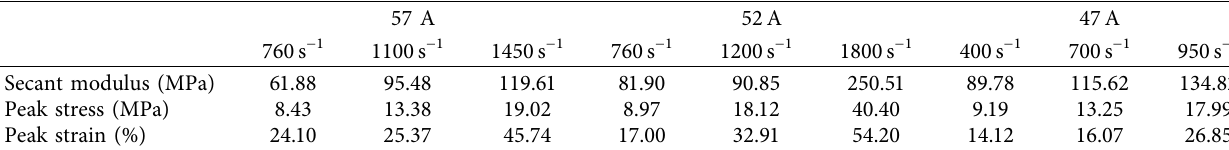
Figure 10: Dynamic tensile stress-strain curves of PVC elastomers with three types of Shore hardness. Table 1: Table 1Changes in dynamic tensile